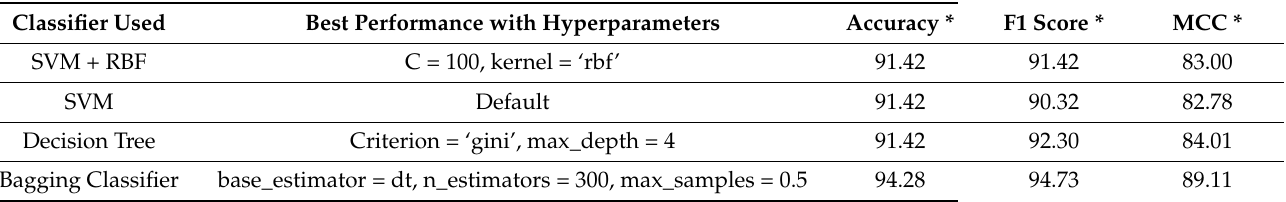
Table 6. Estimated performance over Dataset-1 under case-3.